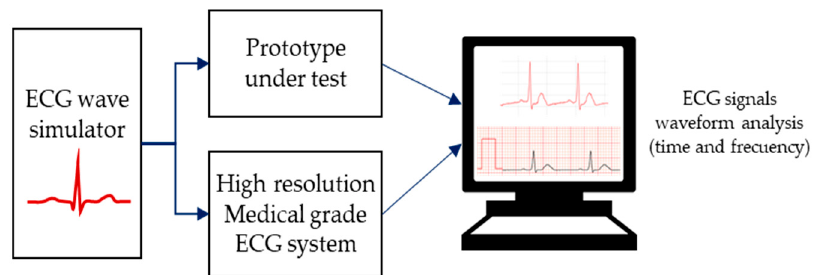
Figure 12. Amplitude calibration setup.